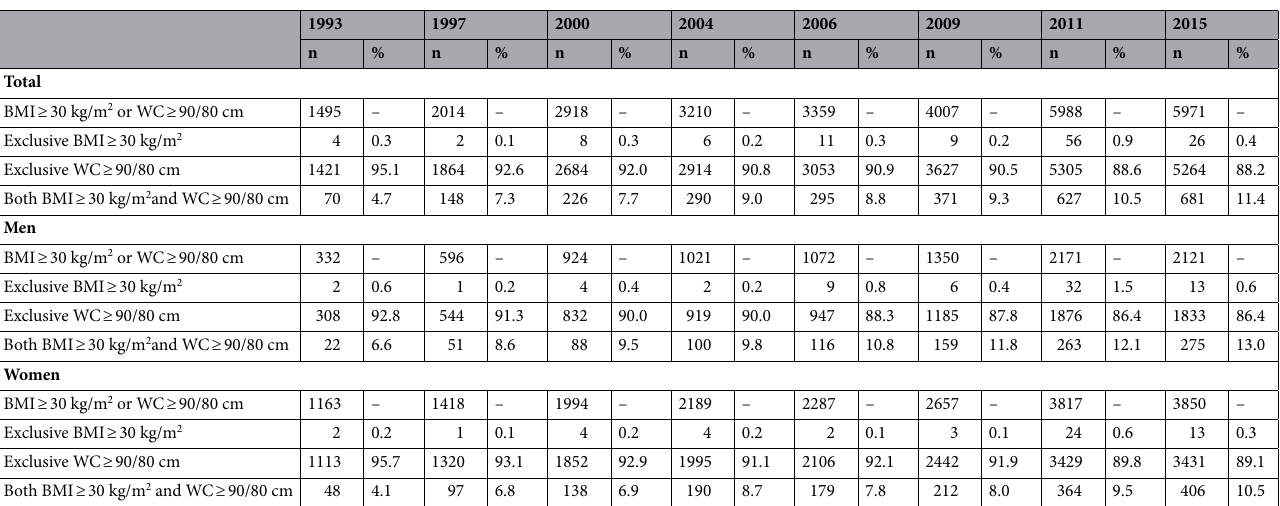
Table 3. Overlap between body mass index (≥ 30 kg/m 2 )- and waist circumference-based obesity among Chinese adults. Proportions of obesity based on both WC ≥ 90/80 cm and BMI ≥ 30 kg/m 2 (overlap between BMI- and WC-based obesity) is calculated as the number of obesity based on both WC ≥ 90/80 cm and BMI ≥ 30 kg/m 2 divided by the number of obesity based on either WC ≥ 90/80 cm or BMI ≥ 30 kg/m 2 . Likewise, proportions of exclusive general obesity and exclusive central obesity are calculated by the similar